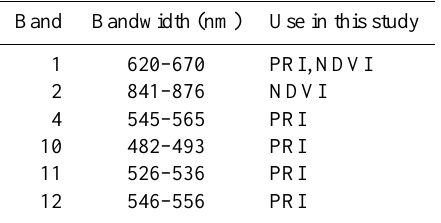
Table 2. Bandwidth of the MODIS spectral bands used in this study. The narrow red bands 13 and 14 were excluded right from the begin- ning because they tend to saturate over land (Goerner et al., 2009). Use in this